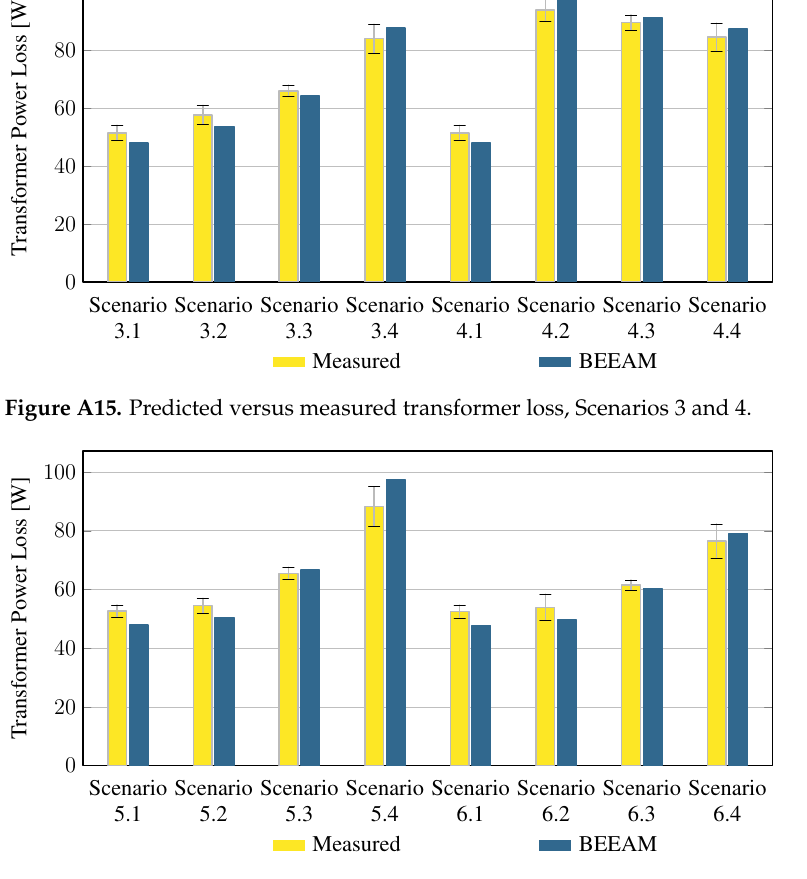
Figure A16. Predicted versus measured transformer loss, Scenarios 5 and 6.